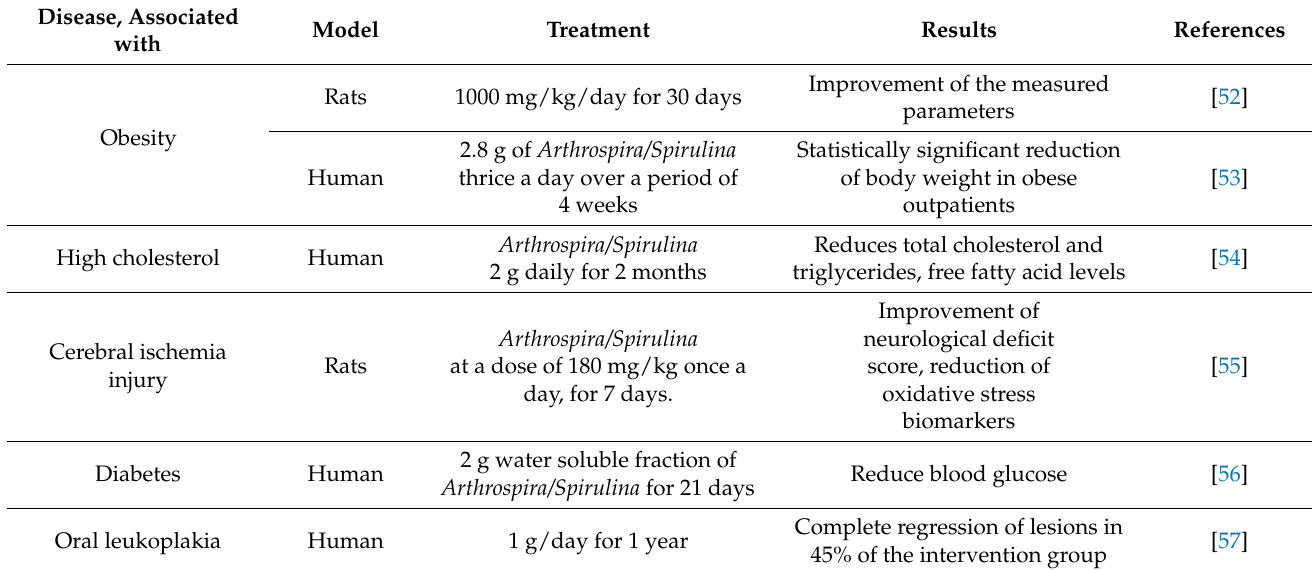
Table 3. Effects of the use of Arthrospira/Spirulina against various diseases.